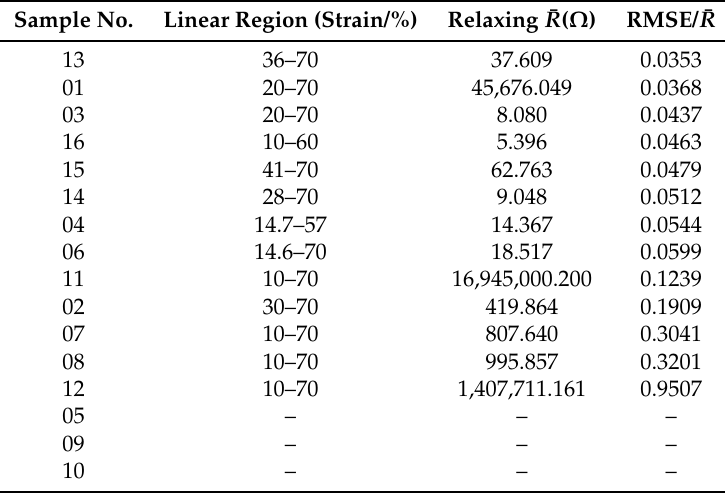
Table 4. Each sample’s linearity performance while relaxing (ranked by RMSE). Samples 05, 09, and 10 did not produce usable data, so were excluded from the analysis. Sample No.